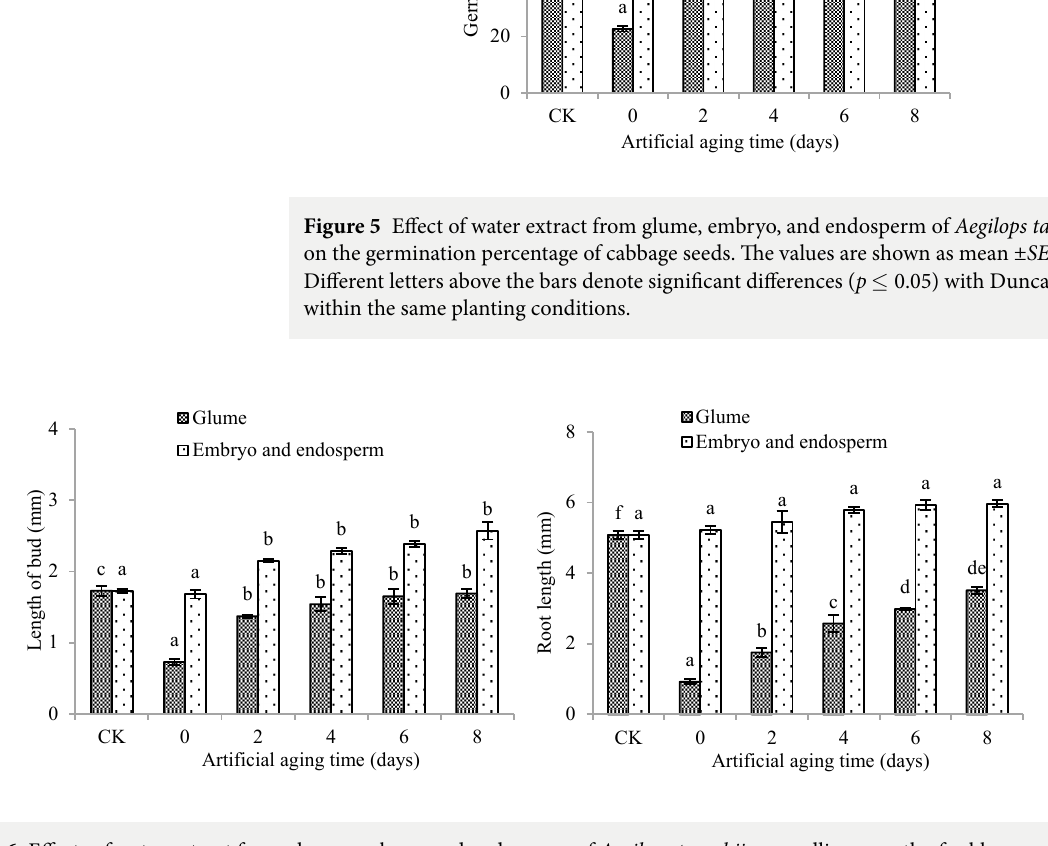
Figure 6 Effects of water extract from glume, embryo, and endosperm of Aegilops tauschii on seedling growth of cabbage seeds. e values are shown as mean ± SE . Different letters above the bars denote significant differences ( p ≤ 0.05) with Duncan’s test within the same planting